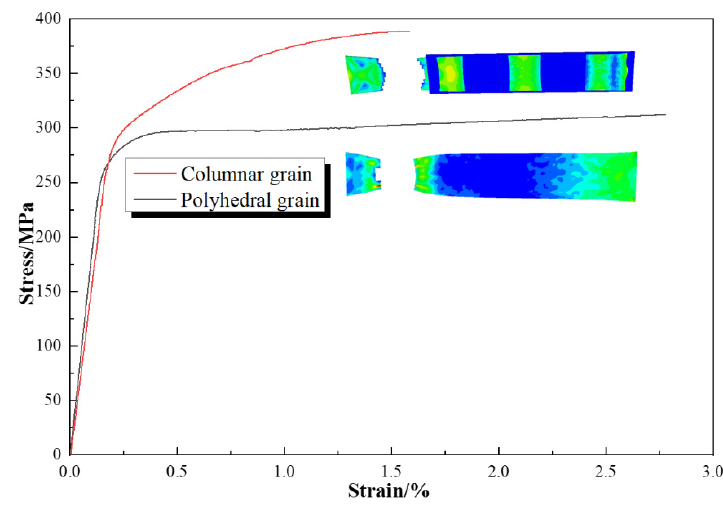
Figure 11. Comparison results of stretching with different microstructures.